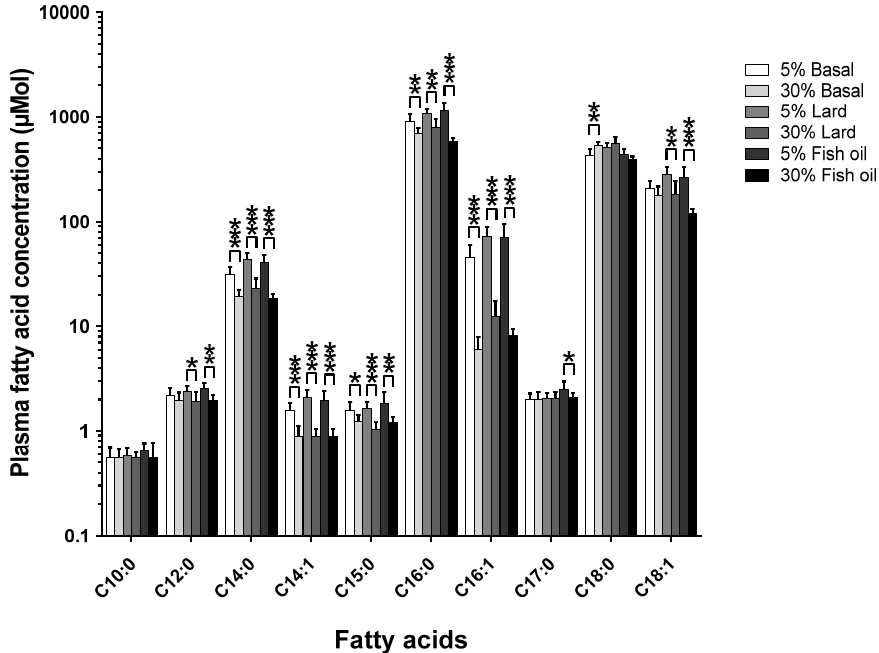
Figure 2. The effect of changing the amount of total-fat within the diet (% energy) from 11% to 51% on the plasma fatty acid concentration ( µ mol) across three different formulations of dietary fat (Basal, Lard, and Fish oil) ( n = 6–8 per group). This is to see if the amount of total-fat within the diet influences the plasma fatty acid concentration independent of the dietary fatty acid composition. The plasma samples were analysed by gas chromatography separation with mass spectrometry detection. The significance of the difference between each group is shown by the p -value star system, where p ≤ 0.05 was considered significant ( p < 0.05 = *, p < 0.01 = **, p < 0.001 = ***). Error bars represent ± standard error of the mean.